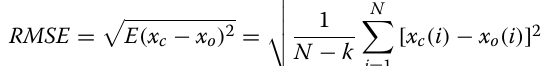
k t k dt D k ( x ) = k 0 e t − 1 x k (cid:31)